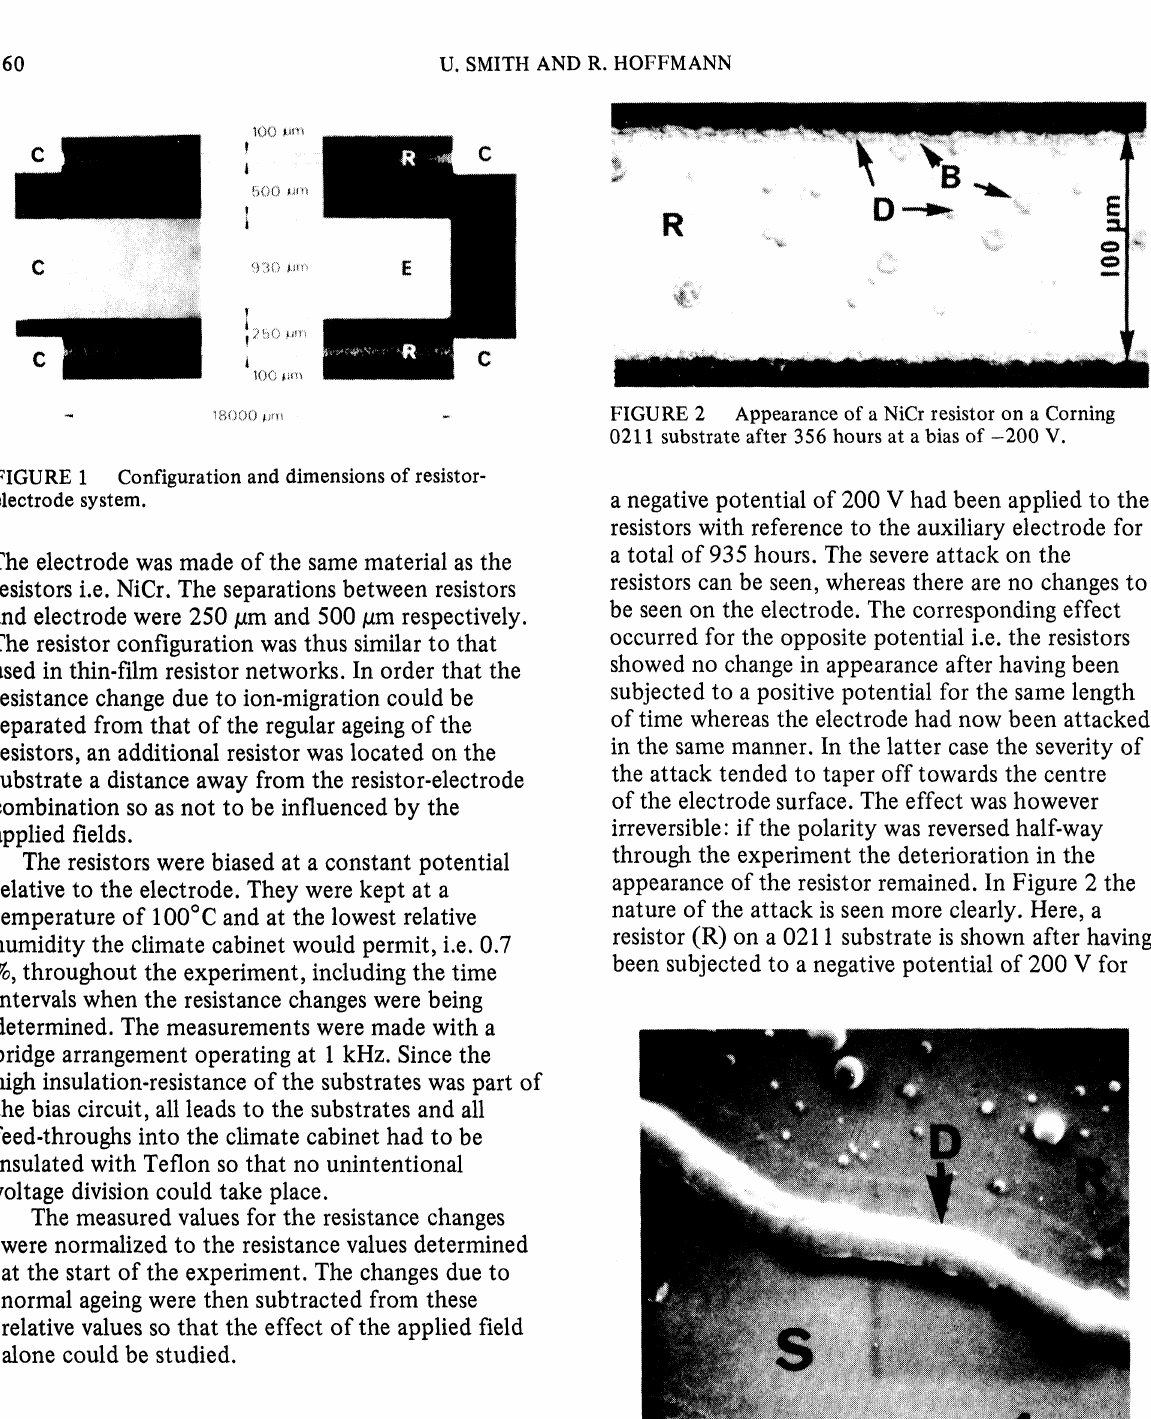
FIGURE 3 Scanning electron micrograph of a NiCr resistor after 56 hours at a bias of-200